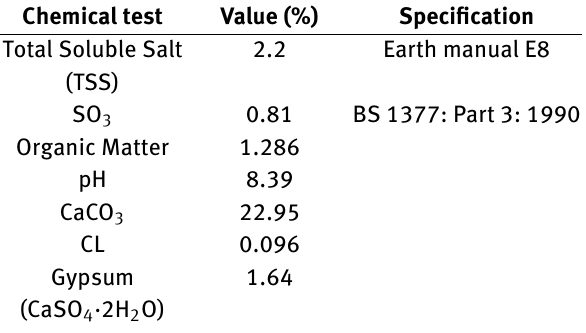
Table 2: Chemical test of soil